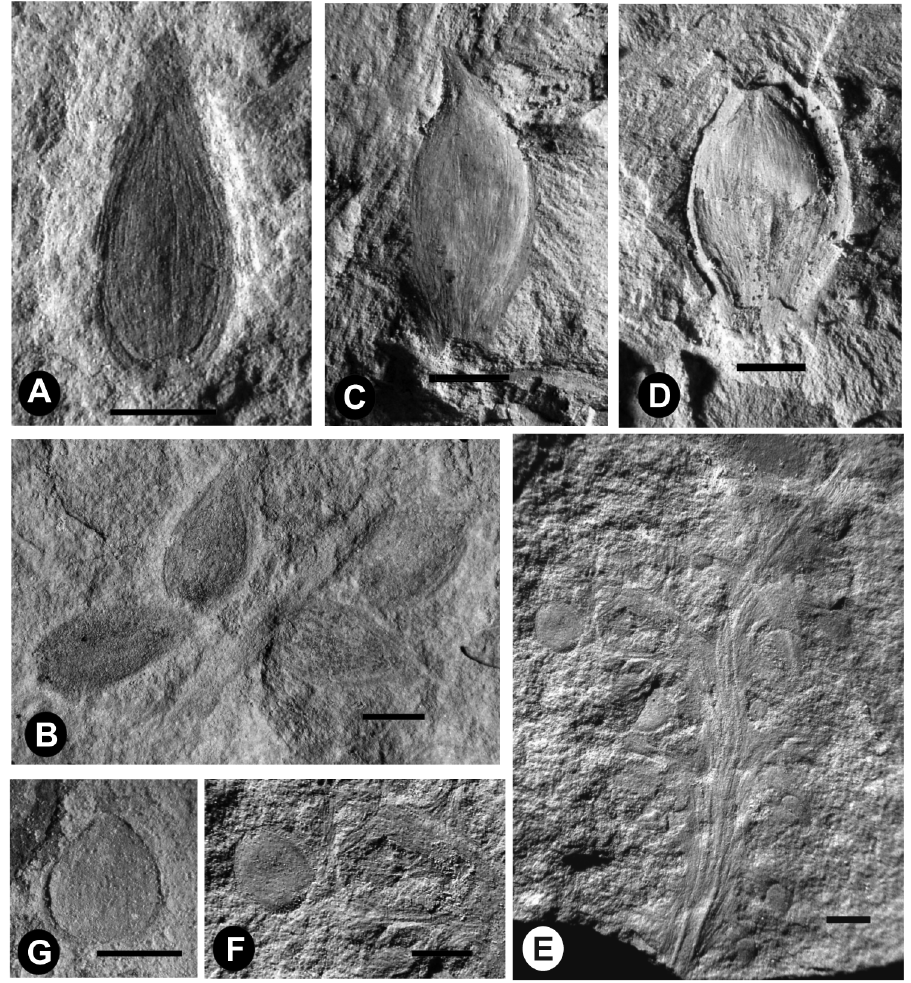
Figure 3: A , MP-Pb 2808C, Cordaicarpus cerronegrensis , complete specimen; B , MP-Pb 4392b, Cordaicarpus cerronegrensis , fructification with seeds associated; C , MP-Pb 3969B, Cordaicarpus truncata, complete specimen; MP- Pb 3969A; D , Cordaicarpus truncata , specimen with scars of degradation; E , MP-Pb 3746, Cordaicarpus aff. C. brasilianus , specimens associated with the Arberia -type fructification; F , MP-Pb 3746, Cordaicarpus aff. C. brasilianus , specimen details; G , MP-Pb 3682A, Cordaicarpus aff. C. brasilianus , complete specimen. Scale bars: 2